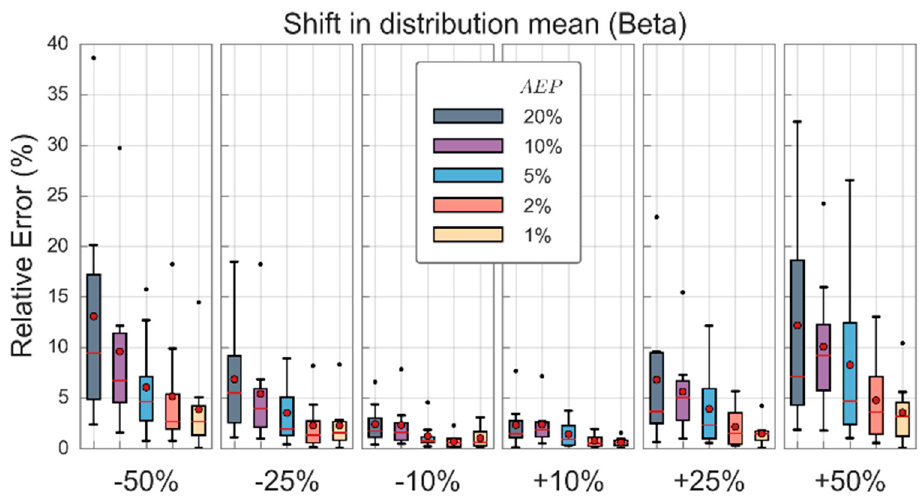
Figure 6. Distribution of relative errors in design flood estimates for each flood quantile across the eight study catchments using distributions with the means shifted by specified percentages (Beta distribution).